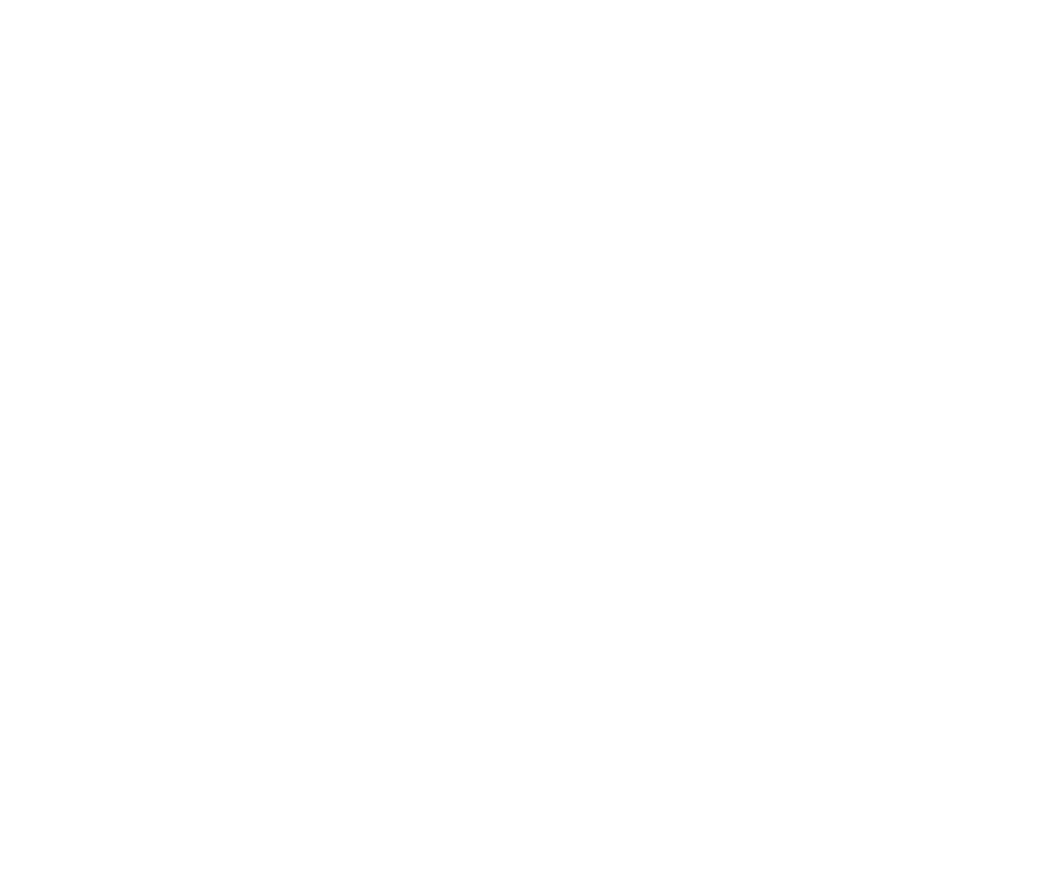
Figure 5. Examples of